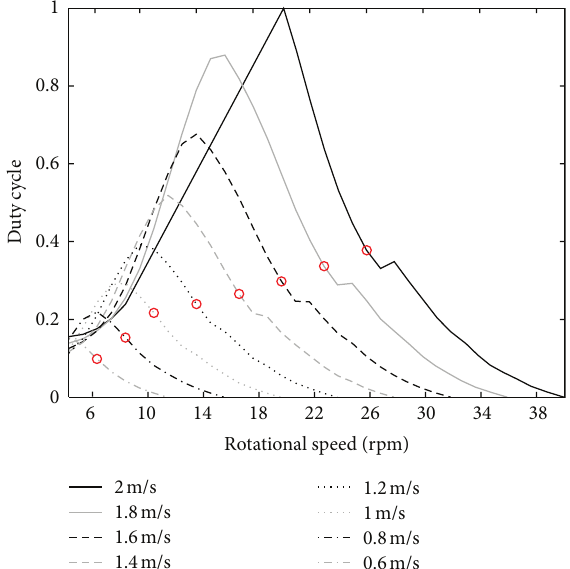
Figure 11: Power output of the system versus tip-speed ratio. The maximum power output for a certain water velocity, marked with a redcircleoneachcurve,isatahighertip-speedratiothanthatwhich maximizes the turbine 𝐶 𝑝 .